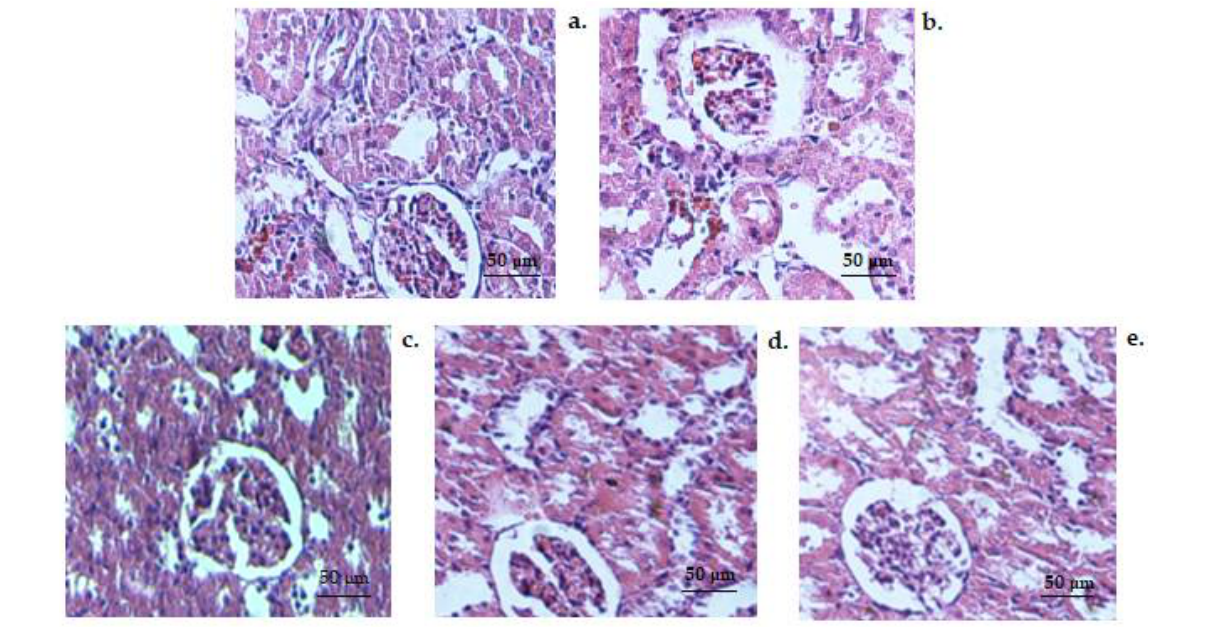
Figure 10. Histopathological images of the kidney structure in the control ( a ), control alcohol ( b ), CHIT ( c ), CHIT-ves ( d ) and AcA ( e ) groups (H&E stain ×20).